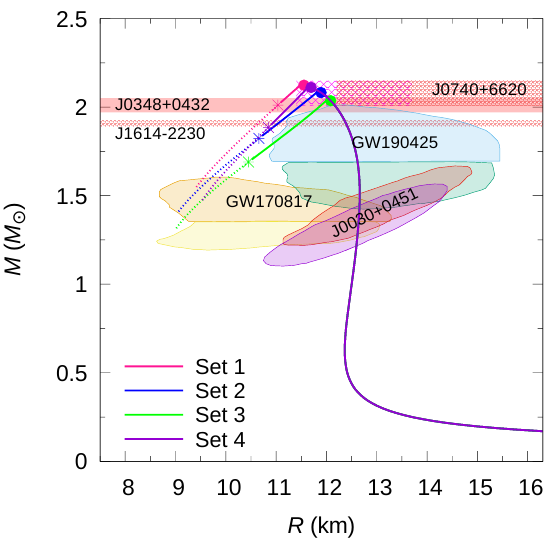
Figure 6. (Color online) M – R relationship of the selected EoSs (Table 4) of this work. The solid dots indicate the appearance of color superconducting quark matter in HSs, which happens just before the maximum-mass peaks are reached. For a rapid conversion of matter, the stellar configurations to the left of each maximum-mass star are unstable. For slow conversions there exist extended branches of stable stars which end at the locations marked with asterisks. The shaded regions (clouds) correspond to constraints imposed by GW170817, GW190425, and NICER observations of PSR J0030+0451. The horizontal pink stripped bands, indicate constraints imposed by pulsars